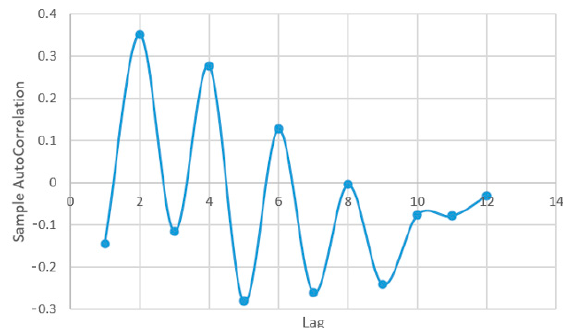
Figure A6. The PAC with transformation in square roots—AH series.